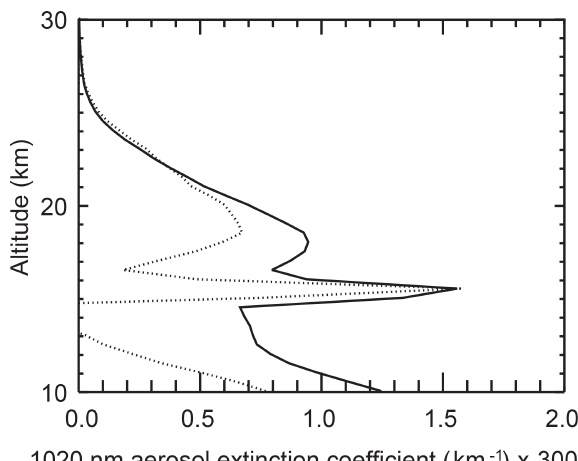
Figure 6. Single profile of 1020nm aerosol extinction coefficient × 300 (dashed line), along with the computed LOS optical depth (solid line). The extinction coefficient, particularly below the cloud located near 15km, is clearly not representative of the impact of aerosol on ozone determinations at that